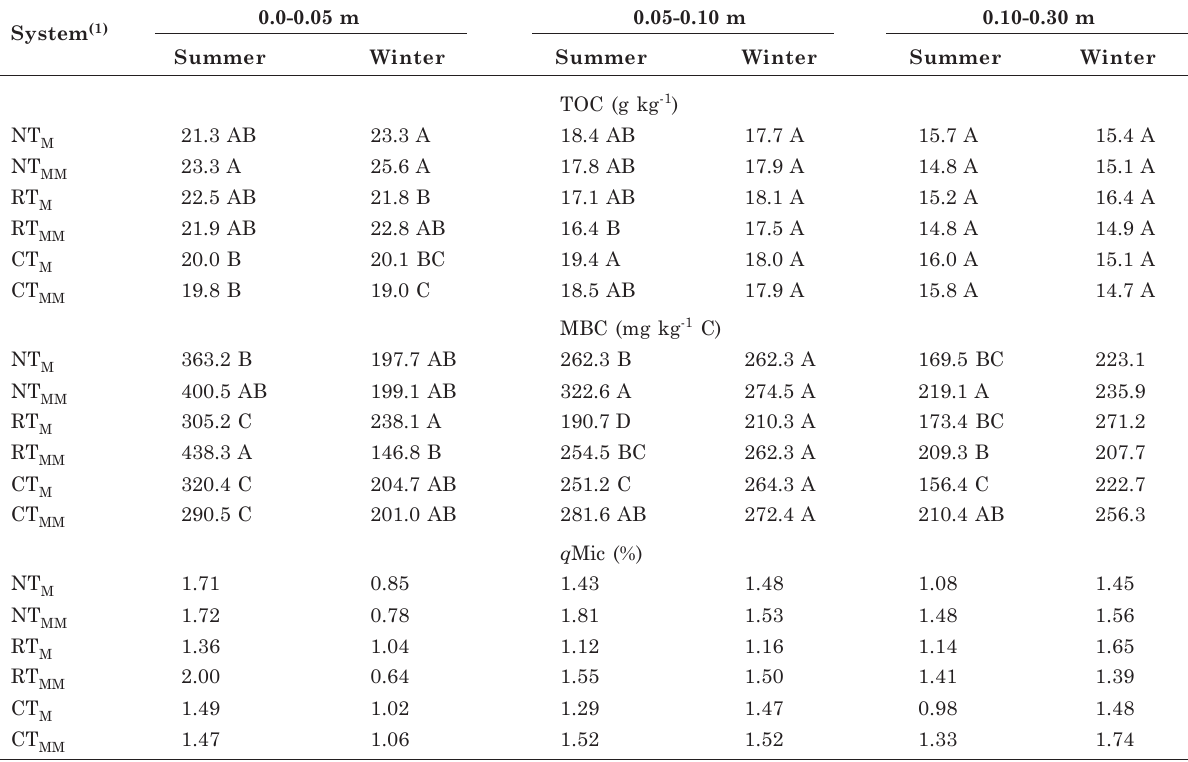
(1) NT: no-tillage; RT: reduced tillage; CT: conventional tillage; M: maize monoculture; MM: maize- Mucuna aterrima intercrop. Means followed by the same letter in the column do not differ from each other by the Tukey test at 5